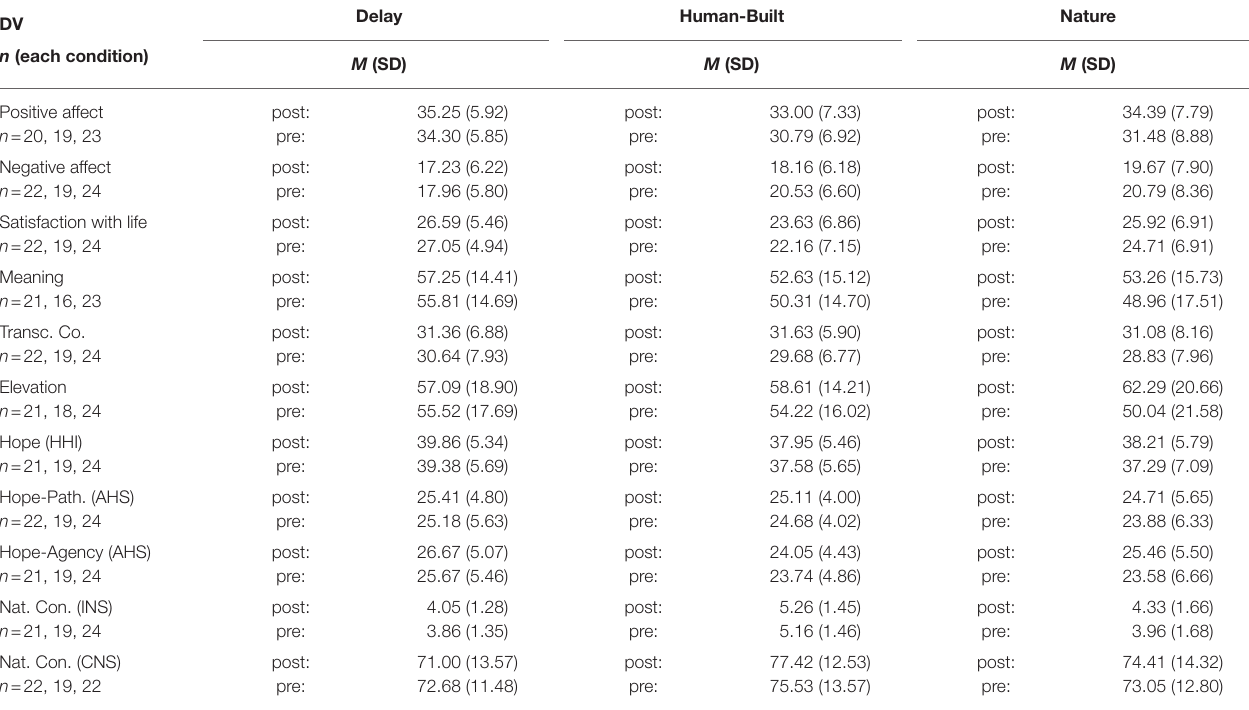
TABLE 2 | Descriptive statistics.